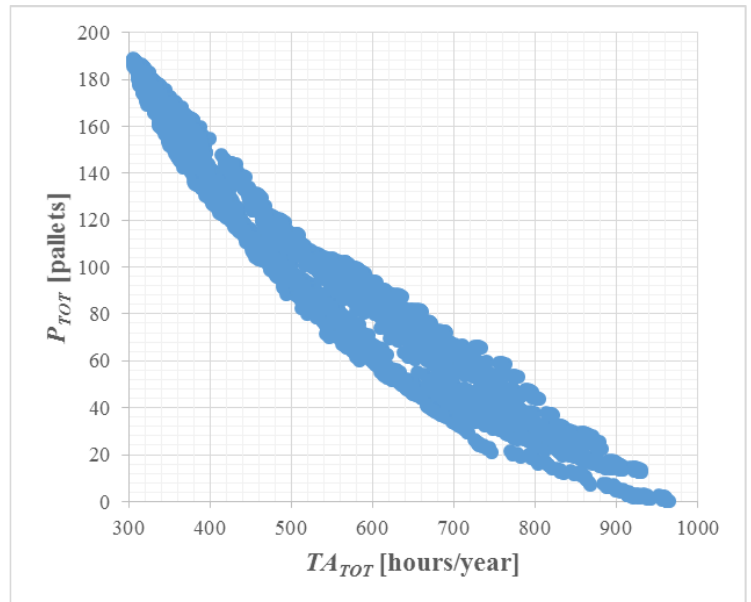
and 𝐸𝑃𝑄 calculation and potential MTO zone. Figure 7. Case study a i and EPQ i calculation and potential MTO zone. 𝑖 𝑖